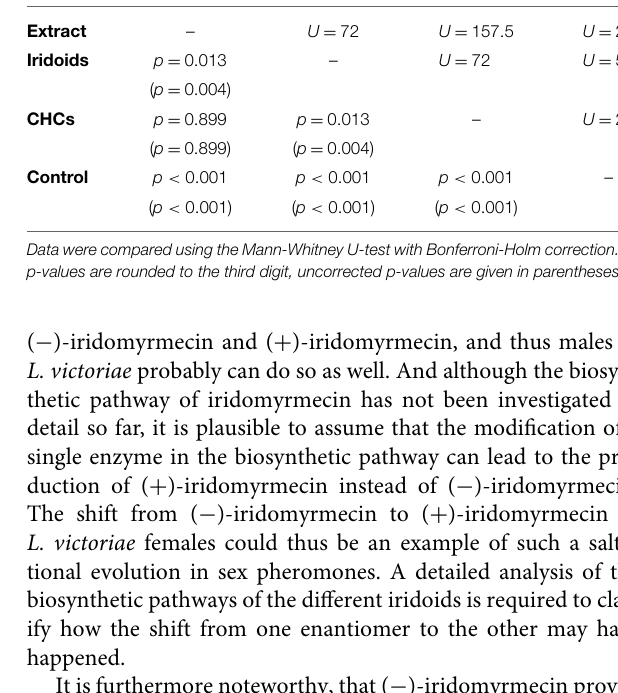
TABLE 6 | Statistical details for the pairwise comparisons of courtship duration toward extract, fractions, and control for L. victoriae .